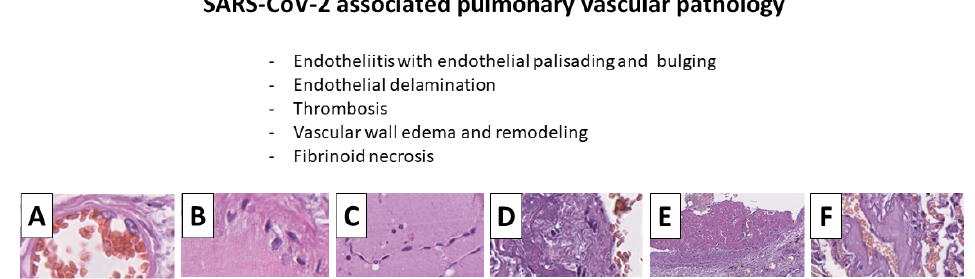
Figure 4. SARS-CoV-2 associated pulmonary vasculature pathology: ( A ) endothelial cell edema; ( B ) endothelial cell palisading; ( C ) endothelial cell desquamation in groups; ( D ) fibrinoid necrosis; ( E ) fibrin thrombus with organization partially attached to the wall of a large vessel; ( F ) homogeniza- tion and thickening of the vascular wall. Note: Histology sections adapted from ref. [60].